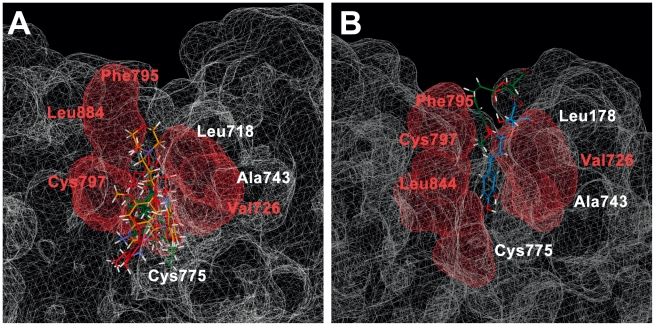
Hydrophobic interactions of different compounds in EGFR.(A) Iressa (orange), Emetine (green), and Rosmaricine (violet) (B) 2-O-Caffeoyl tartaric acid (blue), and 2-O-feruloyl tartaric acid (green). The hydrophobic regions in the binding site are depicted in red, and specific hydrophobic amino acids close to TCM compounds are indicated in red.